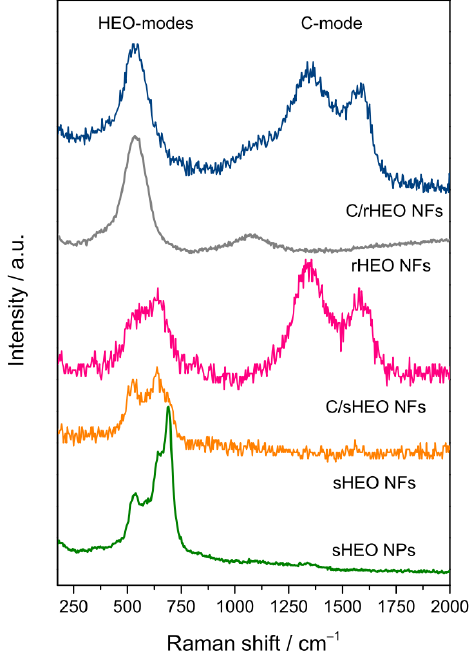
Figure 3. Micro-Raman spectra of the samples.